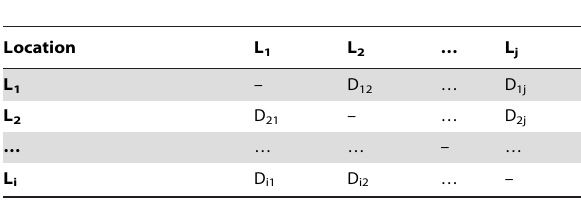
Table 2. Distance matrix for all